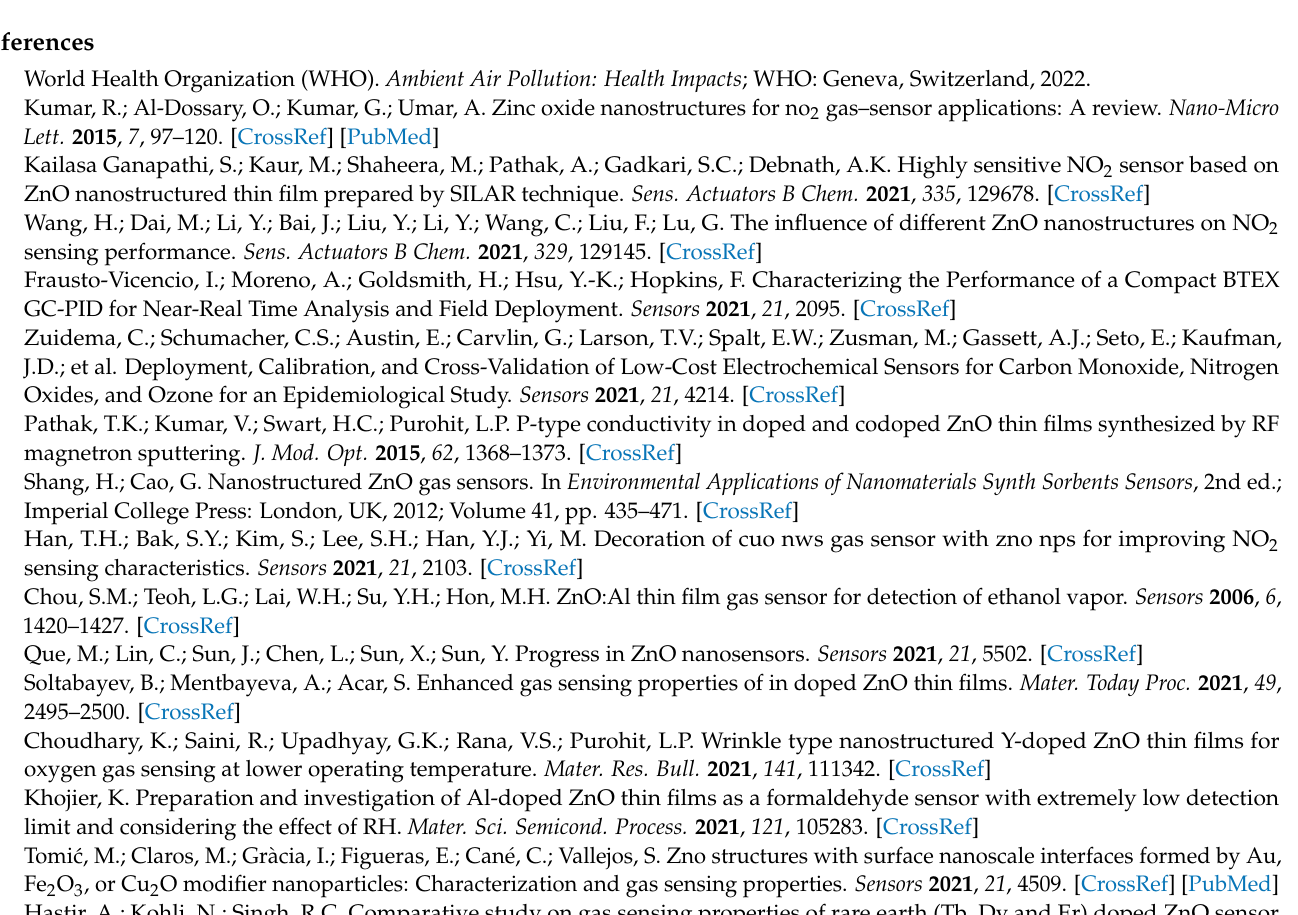
substrate employed. Figure S2: Cross-section of the pure and Dy-doped ZnO thin films; Figure S3: AFM topography for pure (a) and Dy-doped (b) ZnO thin films; Figure S4: Response of pure and Dy-doped ZnO thin films towards 1 ppm of NO 2 at different operating temperatures, ranging from 25 ◦ C to 200 ◦ C. Table S1: Sensitivity values obtained for the pure and Dy-doped ZnO under a dry and a humid atmosphere; Figure S5: Electrical responses when detecting NH3 at 150 ◦